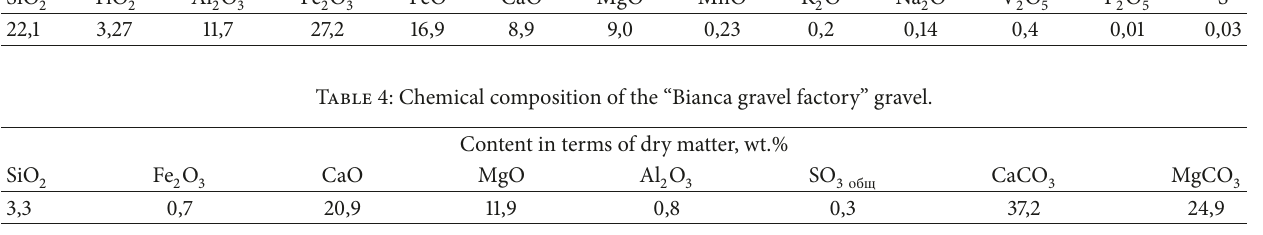
Table 3: Chemical composition of the “Pervouralsk mine management” gravel. Content in terms of dry matter, wt.%